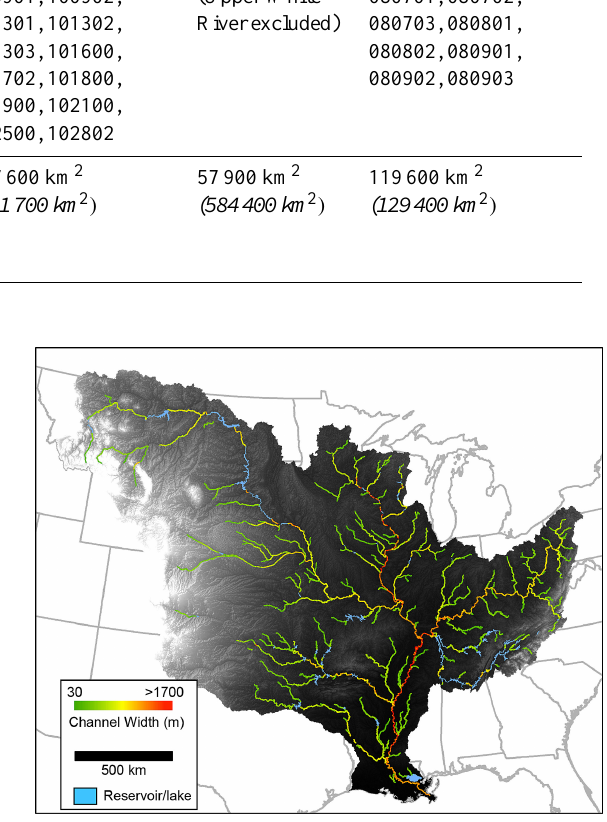
Figure 5. Mississippi River width map (shown with USGS Hy- droSHEDS DEM) of ∼ 1 . 2 × 10 6 observations at 30m resolution based on the NLCD open-water